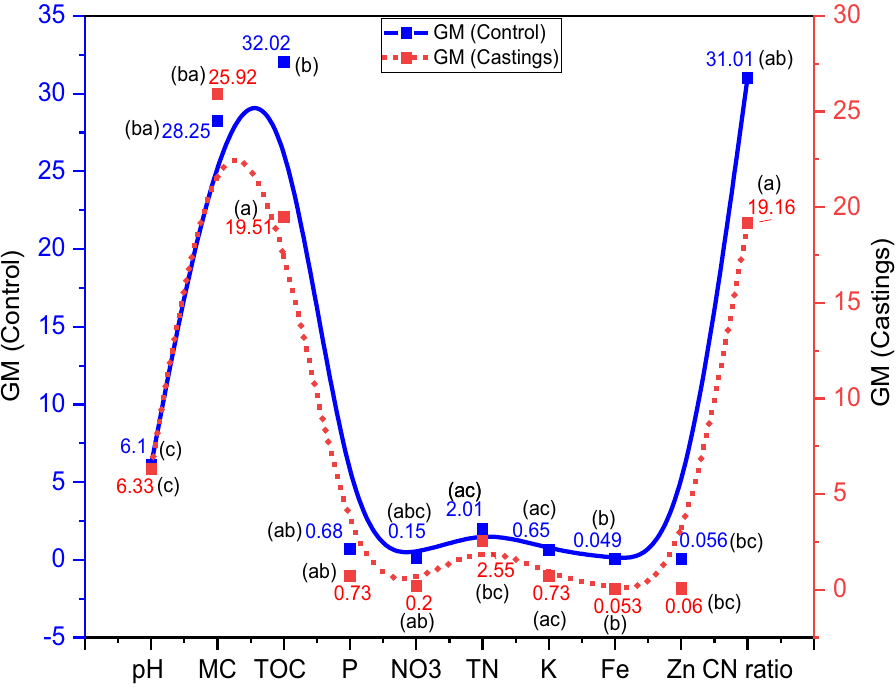
Figure 5. Physico-chemical characteristics of manure (initial) and coprolites of Goat manure (GM) with and without A. caliginosa (mean ± SD). Corresponding means followed with same letters are not significantly different at P <